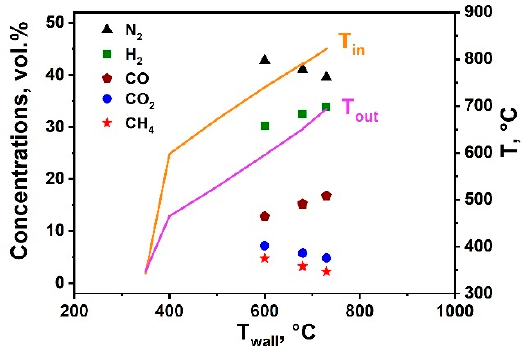
Figure 4. The inlet (T in ) and outlet (T out ) temperatures of the Rh-block and H 2 , N 2 , CO, CO 2 , and CH 4 concentrations (on a dry basis) as a function of reactor wall temperature (T wall ) for PO of MRG. Experimental conditions: GHSV 11,000 h − 1 , 1 bar pressure, reaction mixture (vol.%): 21.5 CH 4 , 11.3 O 2 , 8.8 H 2 O, 5 CO 2 , and 53.4 N 2 .